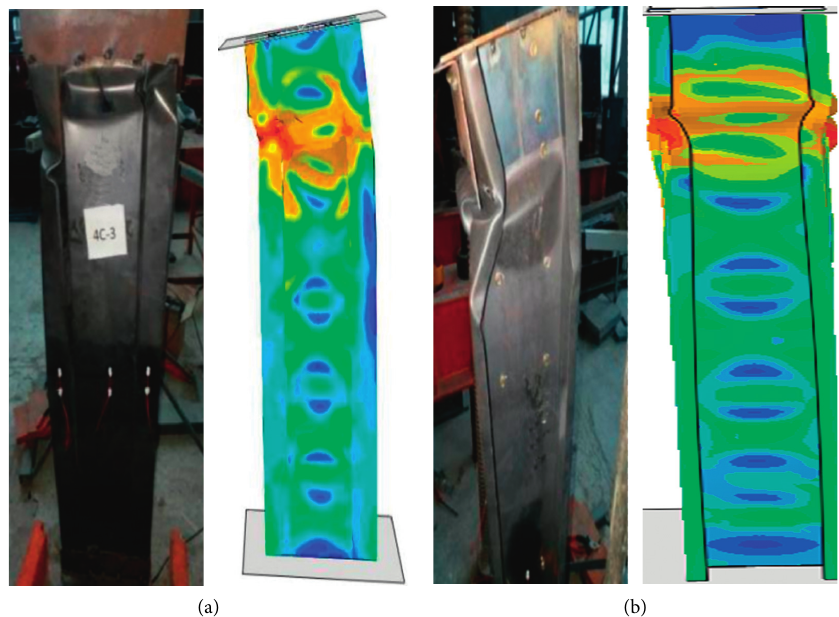
Figure 34: 4C-type failure mode: (a) front elevation and (b) side elevation.